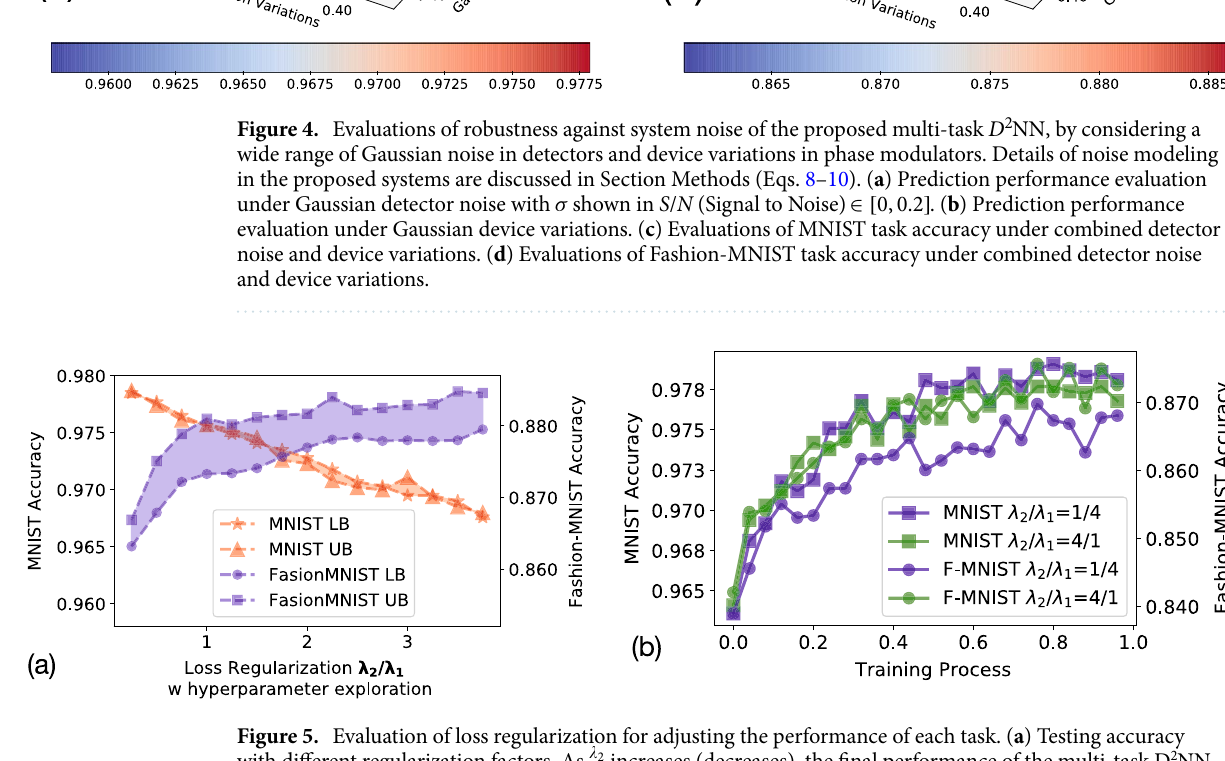
Figure 5. Evaluation of loss regularization for adjusting the performance of each task. ( a ) Testing accuracy (cid:31) 2 with different regularization factors. As (cid:31) 1 increases (decreases), the final performance of the multi-task D 2 NN will be bias to Fashion-MNIST (MNIST). We include results of 100 different hyperparameters for training. ( b ) Testing accuracy of both tasks during the training phase, where we can see that even the largest and smallest regularization factors do not cause